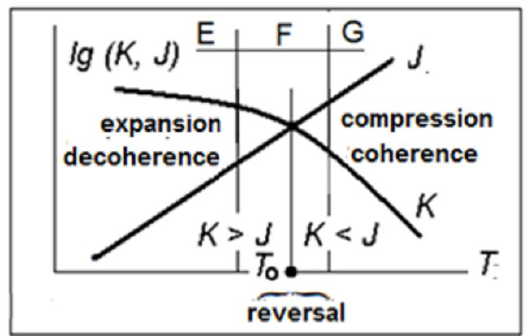
Fig. 3. Scheme of the phase transition in the F-layer after the classical model: K - the rate of condensation of hot vapour, J -the rate of evaporation. Quantum entanglement considers the decoherence and coherence. Essentially there is matter compression or its expansion. When modes alternate, the reversal of the EMF occurs. Top: E-layer, F-layer,